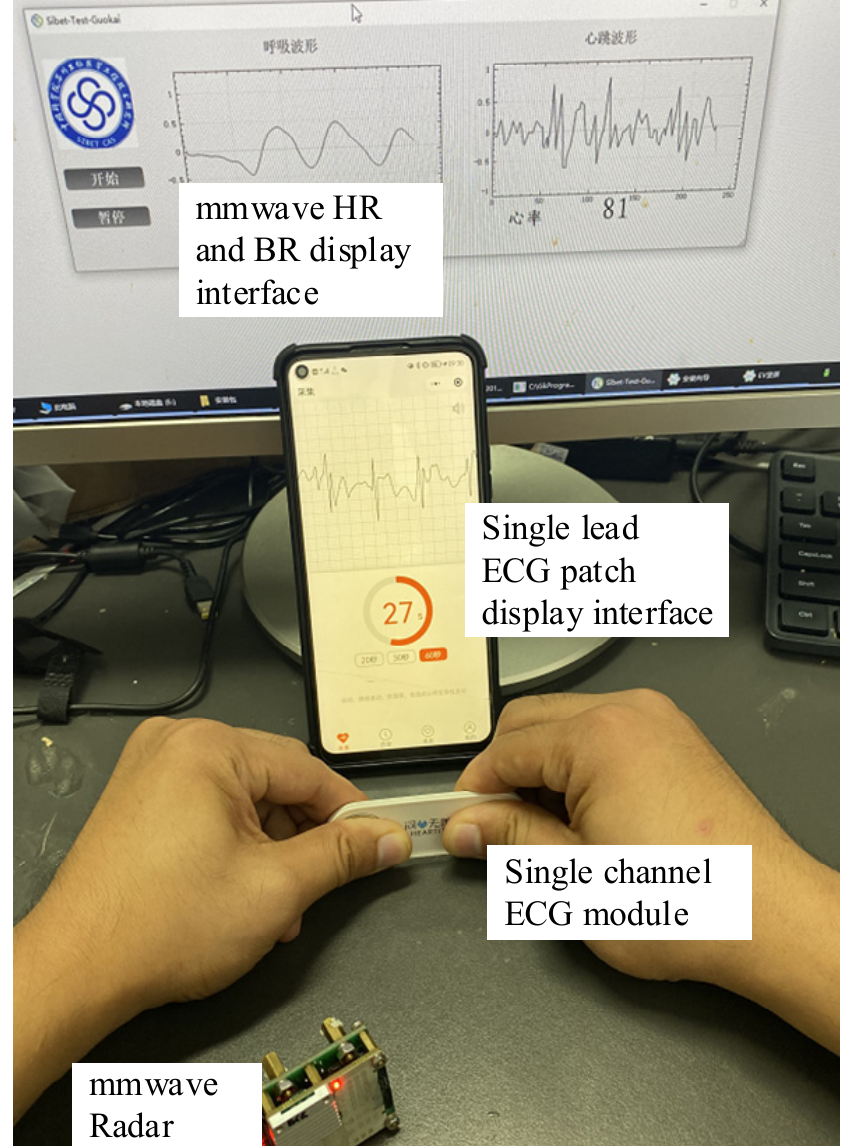
Figure 17. Comparative experiment of millimeter wave radar and single channel ECG module. Then, through the comparative experiment of millimeter wave radar and single channel ECG module in Figure 18, ECG signal and heartbeat signal were collected simulta-